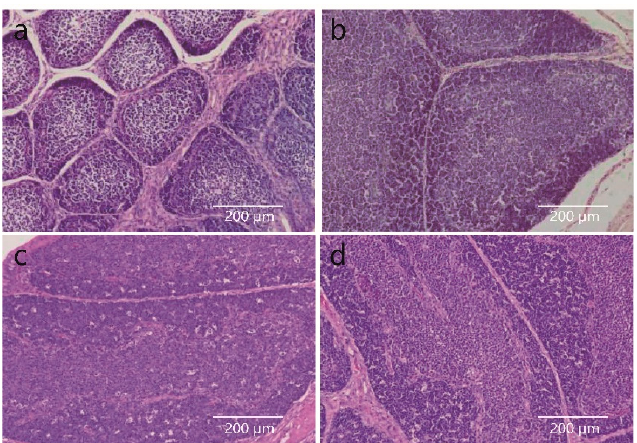
Figure 1. Histomorphological image of a BF at 4 different stages: 7 d ( a ), 42 d ( b ), 90 d ( c ) and 120 d ( d ). Magnification = 200×.